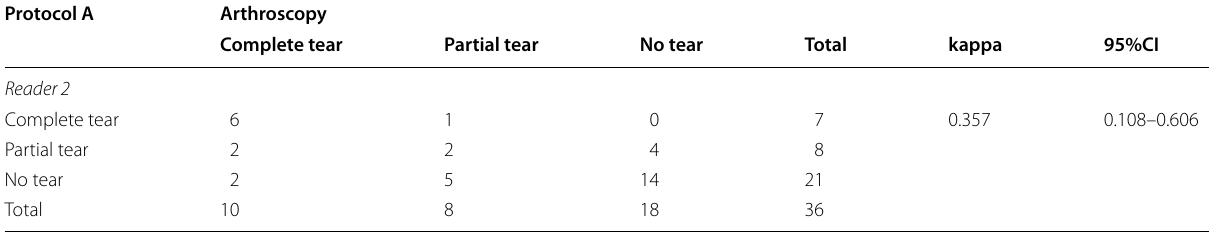
Table 4 MRI grades of ACL graft injury in imaging protocol A versus arthroscopy according to reader 2. Diagnostic agreement between MR grade and arthroscopic grade is also